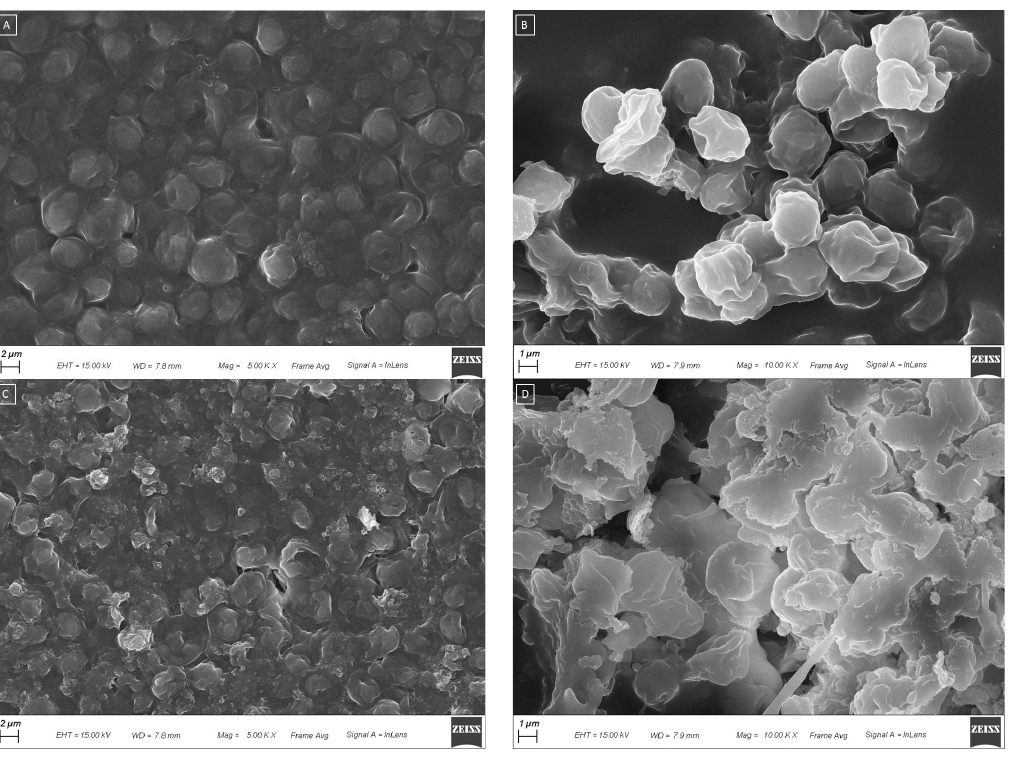
Figure 4. SEM images of ( A ) NWL (5.00K X); ( B ) lyophilized NWL sample (10.00K X); ( C ) SWL (5.00K X); ( D ) and lyophilized SWL (10.00K X).